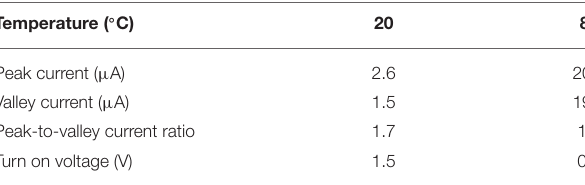
TABLE 1 | Electrical parameters of n-ZnO NRs/p-degenerated diamond heterojunction at 20 and 80 ◦